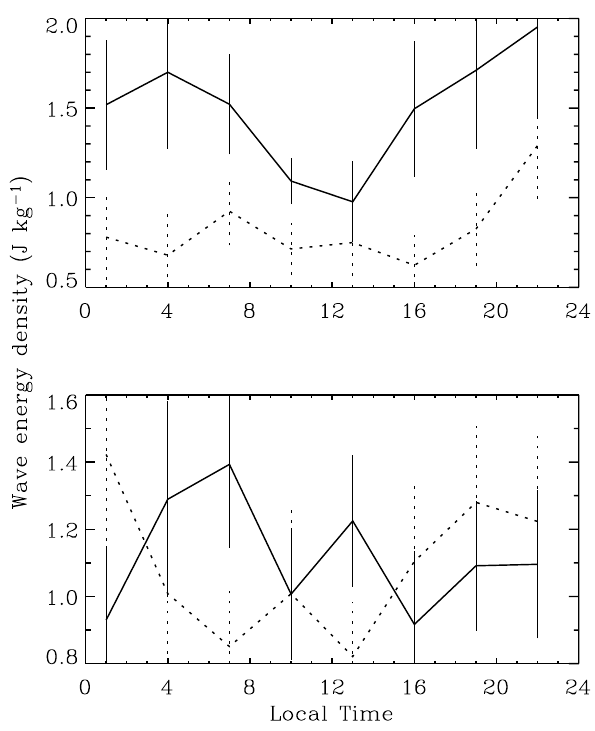
Fig. 4. Monthly averaged local time variations of the GW kinetic energy (solid curves) and potential energy (dotted curves) densities in the troposphere (bottom panel) and lower stratosphere (top panel) in August 2006. The vertical lines denote the standard